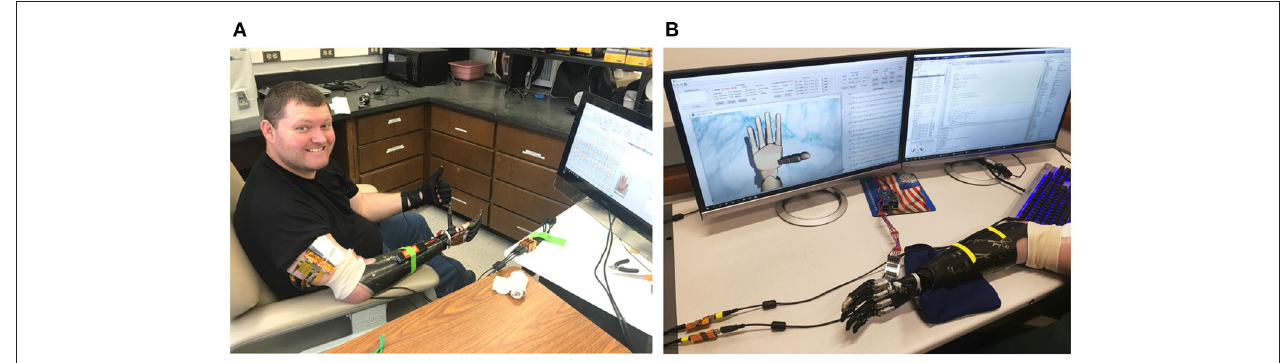
FIGURE 1 | Photo of the (A) amputee and (B) the data collection software during a training session. The patient performs various hand movements repeatedly during the training session. Nerve data and ground-truth movements are collected by a computer and displayed in real-time on the monitor for comparison.